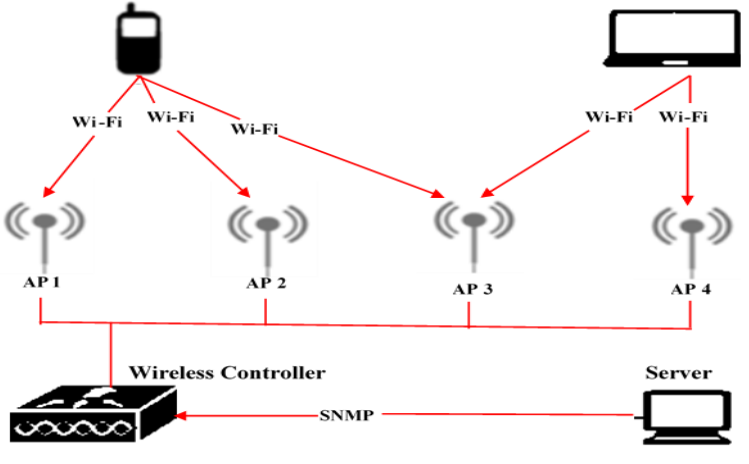
Figure 9. Wi-Fi based localization.